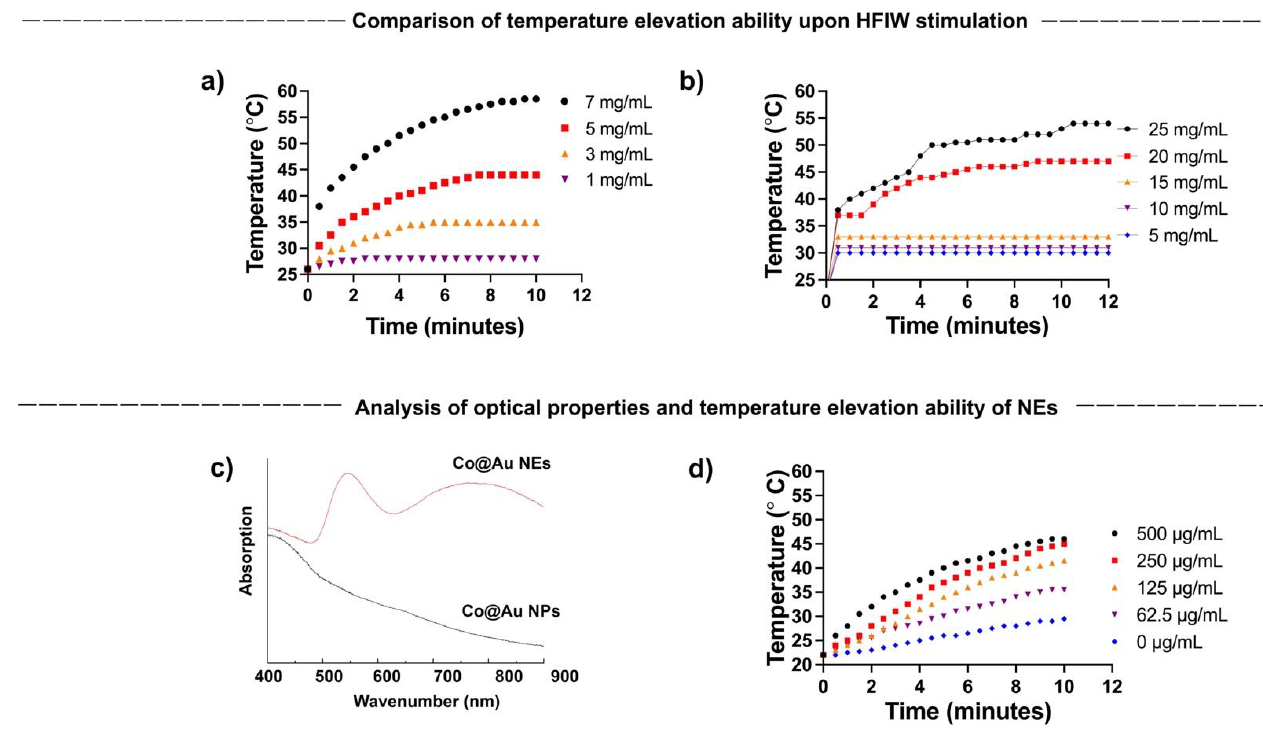
Figure 3. ( a , b ) Concentration-dependent hyperthermia ability of round Co@Au nanoparticles (Co@Au NPs) and elliptical Co@Au (Co@Au NEs) nanoparticles. x -axis highlights time; y -axis temperature ( c ) Analysis of optical properties of Co@Au NPs and NEs via Uv-vis spectrophotometry. ( d ) Concentration-dependent hyperthermia ability of Co@Au NEs upon photostimulation. x -axis highlights time; y -axis temperature.